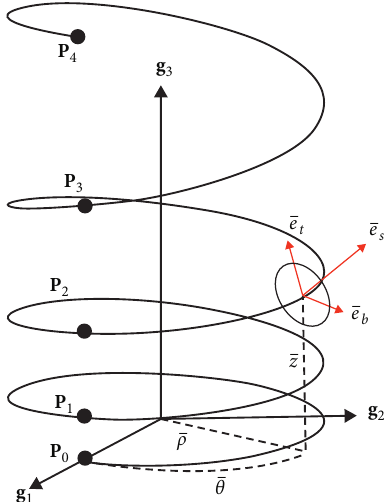
Figure 1: Initial geometric configuration of variable pitch